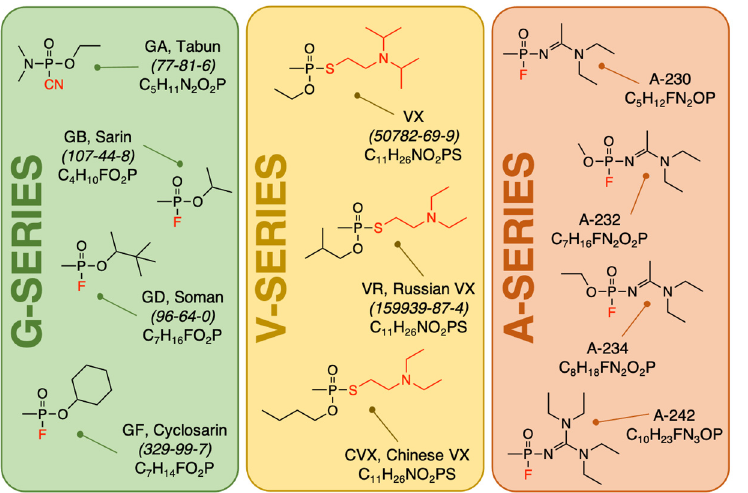
Figure 1. Chemical structures of OPNAs. Degradation products arising from all these three kinds of nerve agents are similar and overlapping in